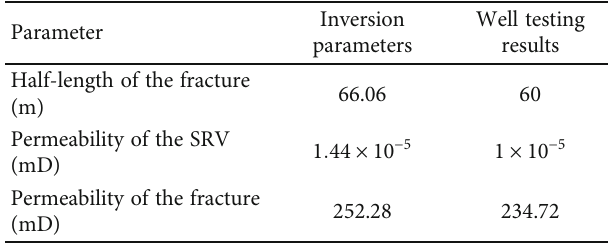
Table 2: Inversion parameters of well